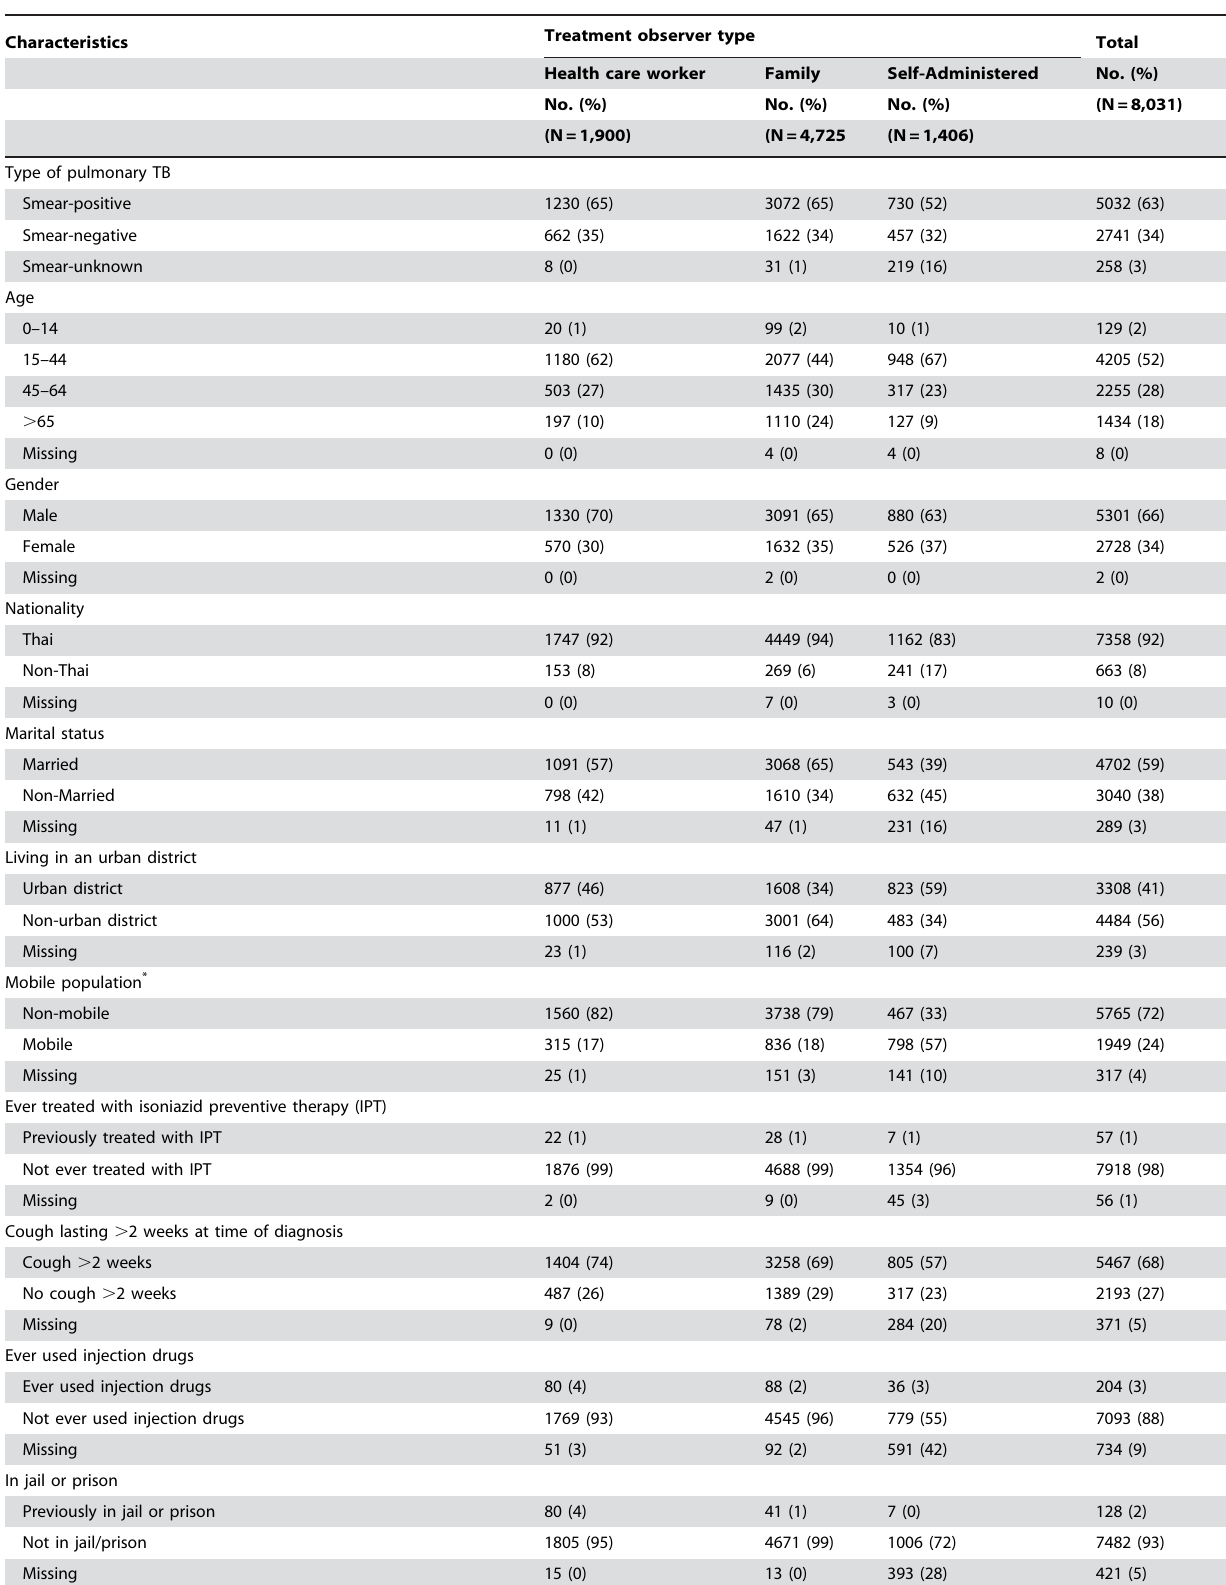
Table 1. Characteristics of pulmonary TB patients eligible for analysis, stratified by type of observer during first two months of TB